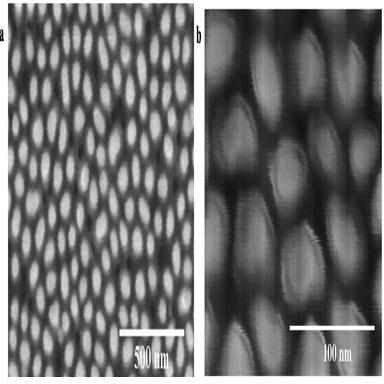
(a) Top view SEM image of gold nanorod sample (b) the top view of nanorods in higher magnification to illustrate the different contrasts between the nanorods' edge and centre.